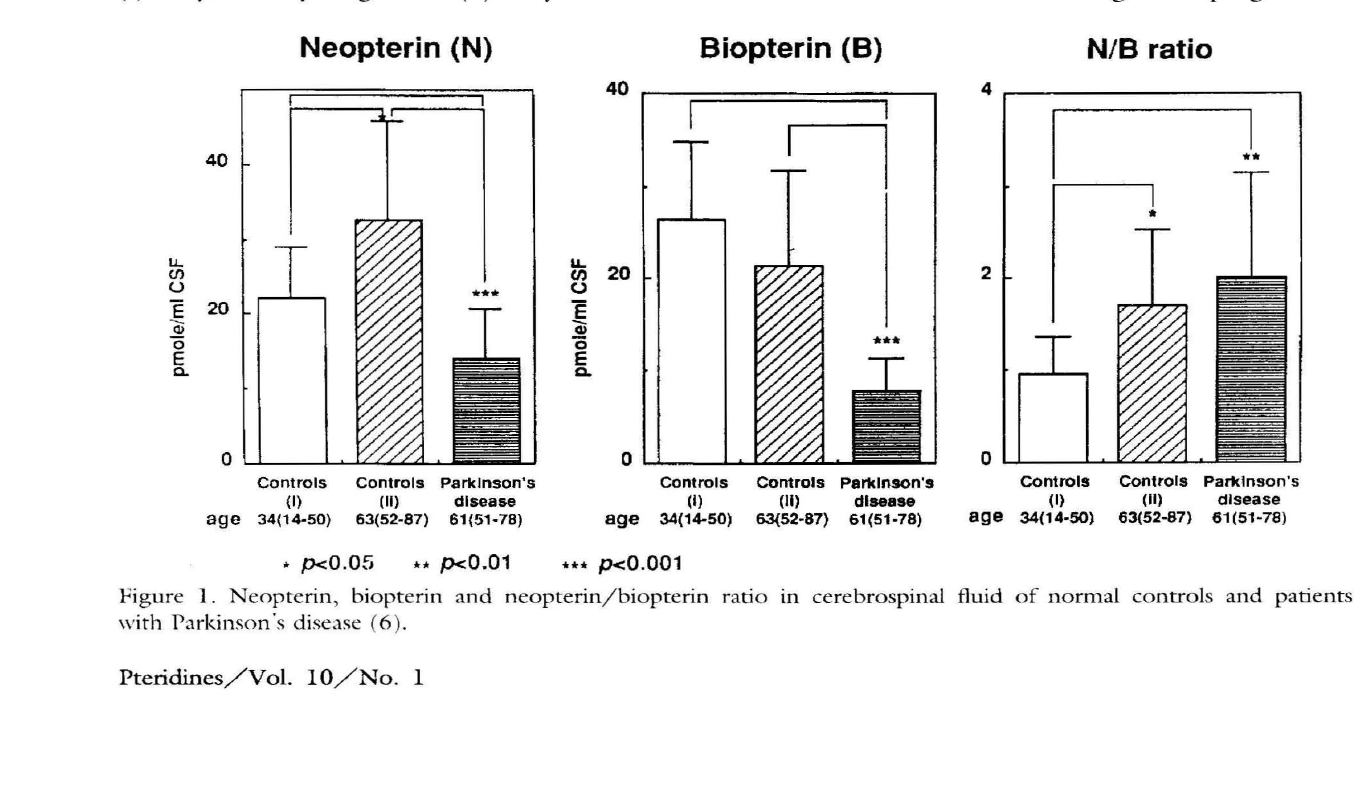
figure 1. Neopterin, biopterin and neopterin/biopterin ratio in cerebrospinal fluid of normal controls and patients with Parkinson's disease (6 ). Pteridines/VoL IO/ No.